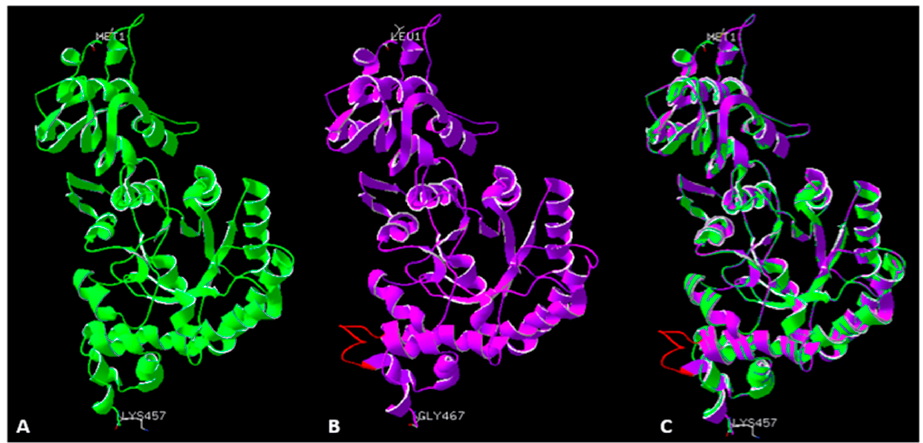
Figure 4. Large subunit monomers from R. palustris ( A ), green ribbon structure), modelled Symbio- dinium sp. Rubisco structure ( B ), violet ribbon structure), and a superimposition of both structures ( C ). Red colour indicates a novel loop (insert 425) in the Symbiodinium sp. Rubisco structure.